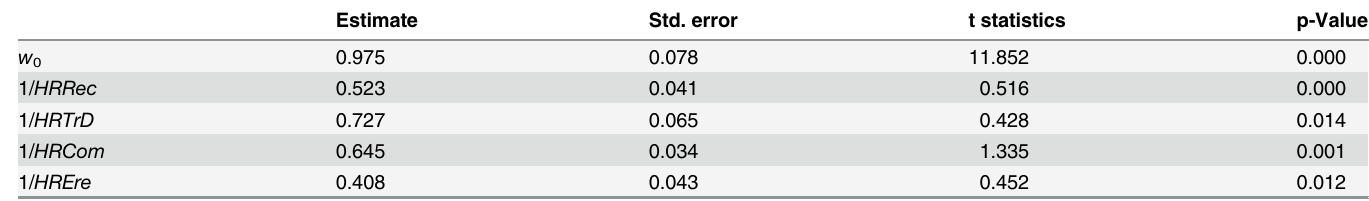
Table 2. Estimated regression model for OvHR.